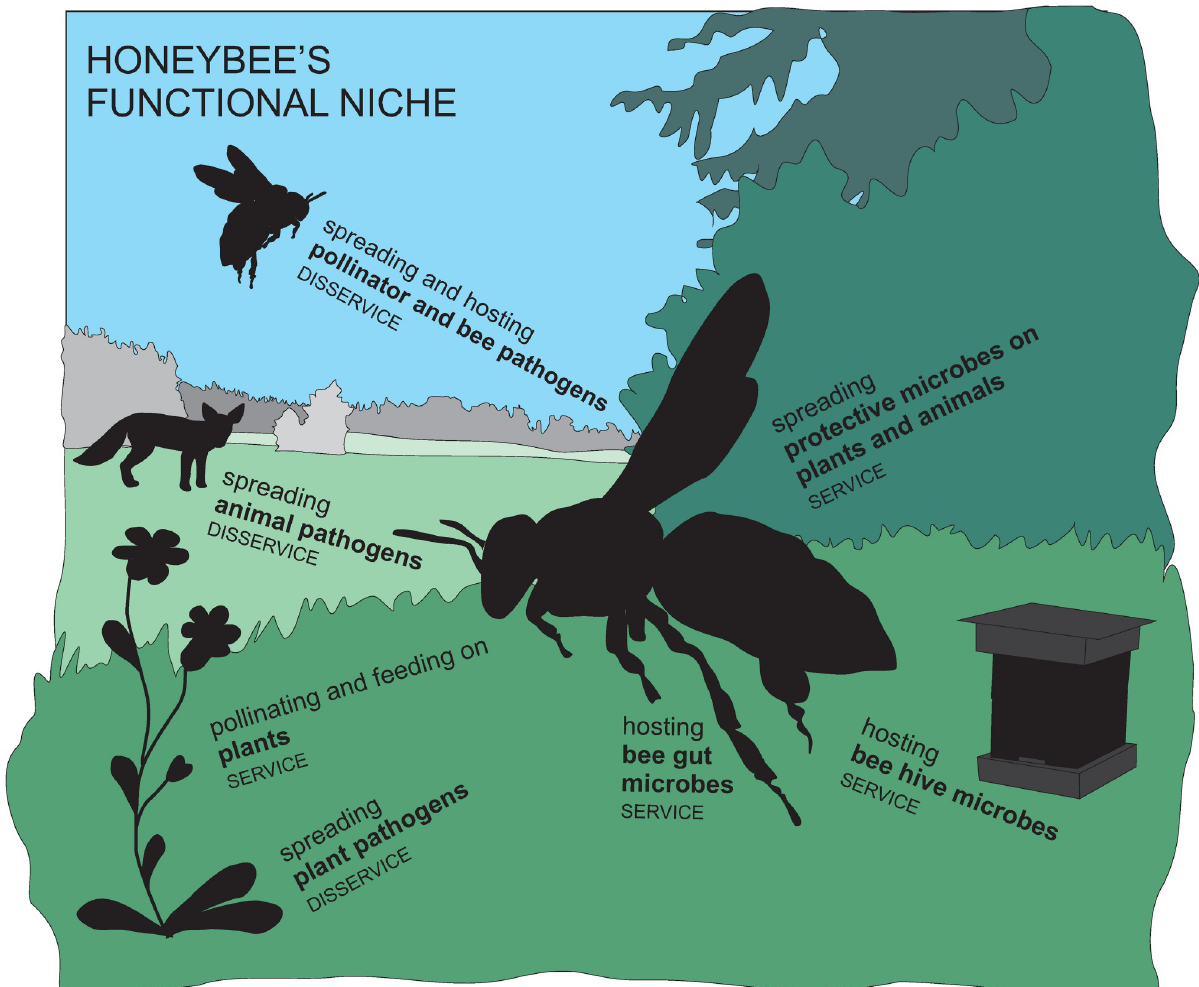
Fig 1. A conceptual figure of the functional niche of honeybees, and the ecosystem services and disservices the functions generate. A conceptual figure of the functional niche of honeybees drawing on previous research [14–17, 27, 28] and the taxa whose DNA we have identified from honey. The taxa as ecological groups are given in bold, with the likely function of honeybees related to this group above it. In small capitals is given whether the function could be considered an ecosystem service or disservice, either by the function honeybees do or what the taxa detected by DNA do to